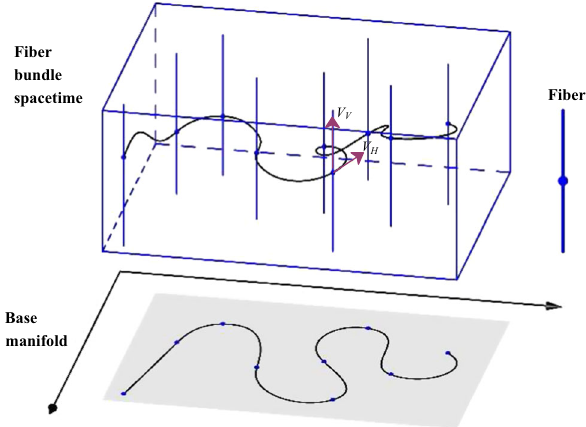
Fig. 1 An illustrative figure for the fiber bundle spacetime. There has a surjective projection π from the fiber bundle spacetime to the base manifold, and each inverse image π − 1 ( x ) ∼= U ( 1 ) is a submanifold of the spacetime and called a fiber. Any tangent vector at a point in the fiber bundle spacetime is always decomposed into a sum, V V + V H , where V V is tangent to the fiber and V H is to point from one fiber to another. Note that, the original figure is given in Ref.